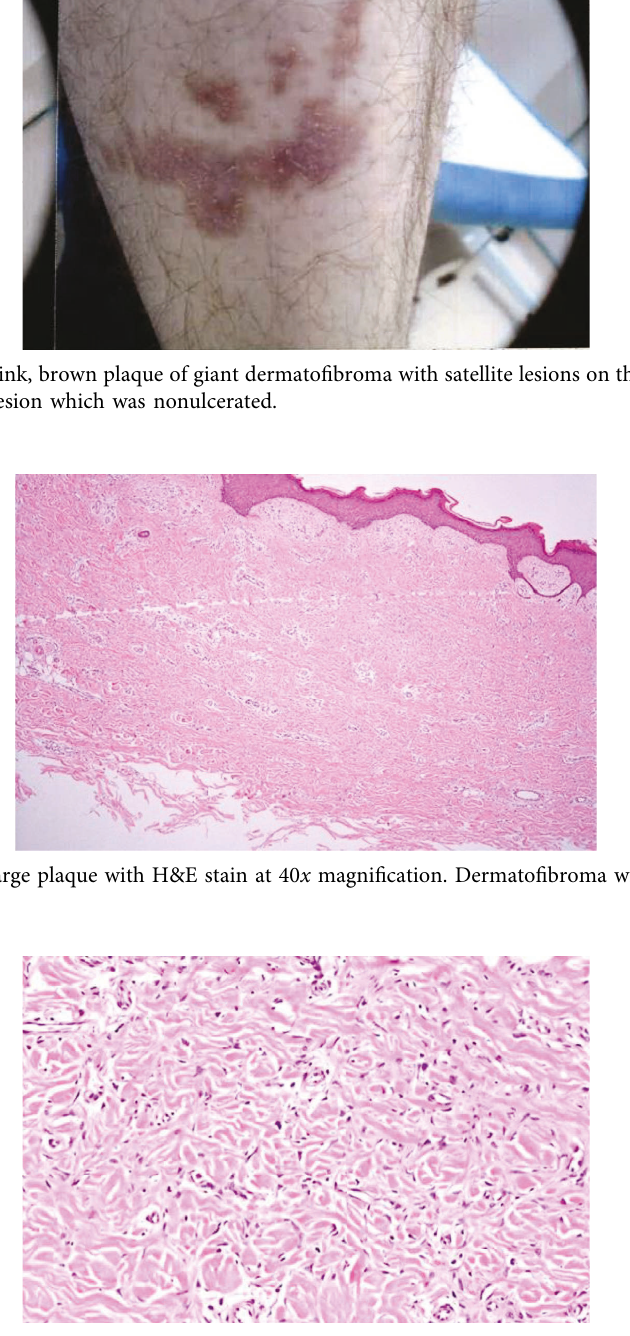
Figure 3: Histopathology H&E stain (magnification × 100). Weaving bland spindle cells around reticular collagen in the